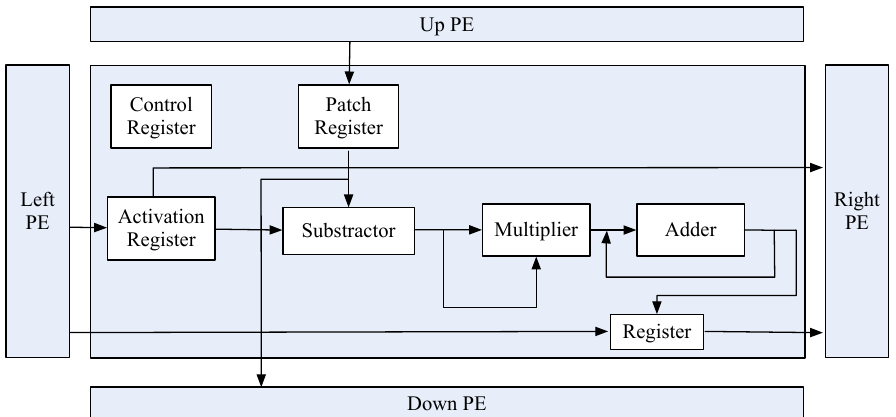
Figure 3. Schematic diagram of a single PE in SAFA. Unlike the traditional systolic array where the PE performs MAC operation, our designed PE implements subtraction, multiplication, and accumulation operations to carry out the reduced GRBF function (details are illustrated in Section 2) in the S2